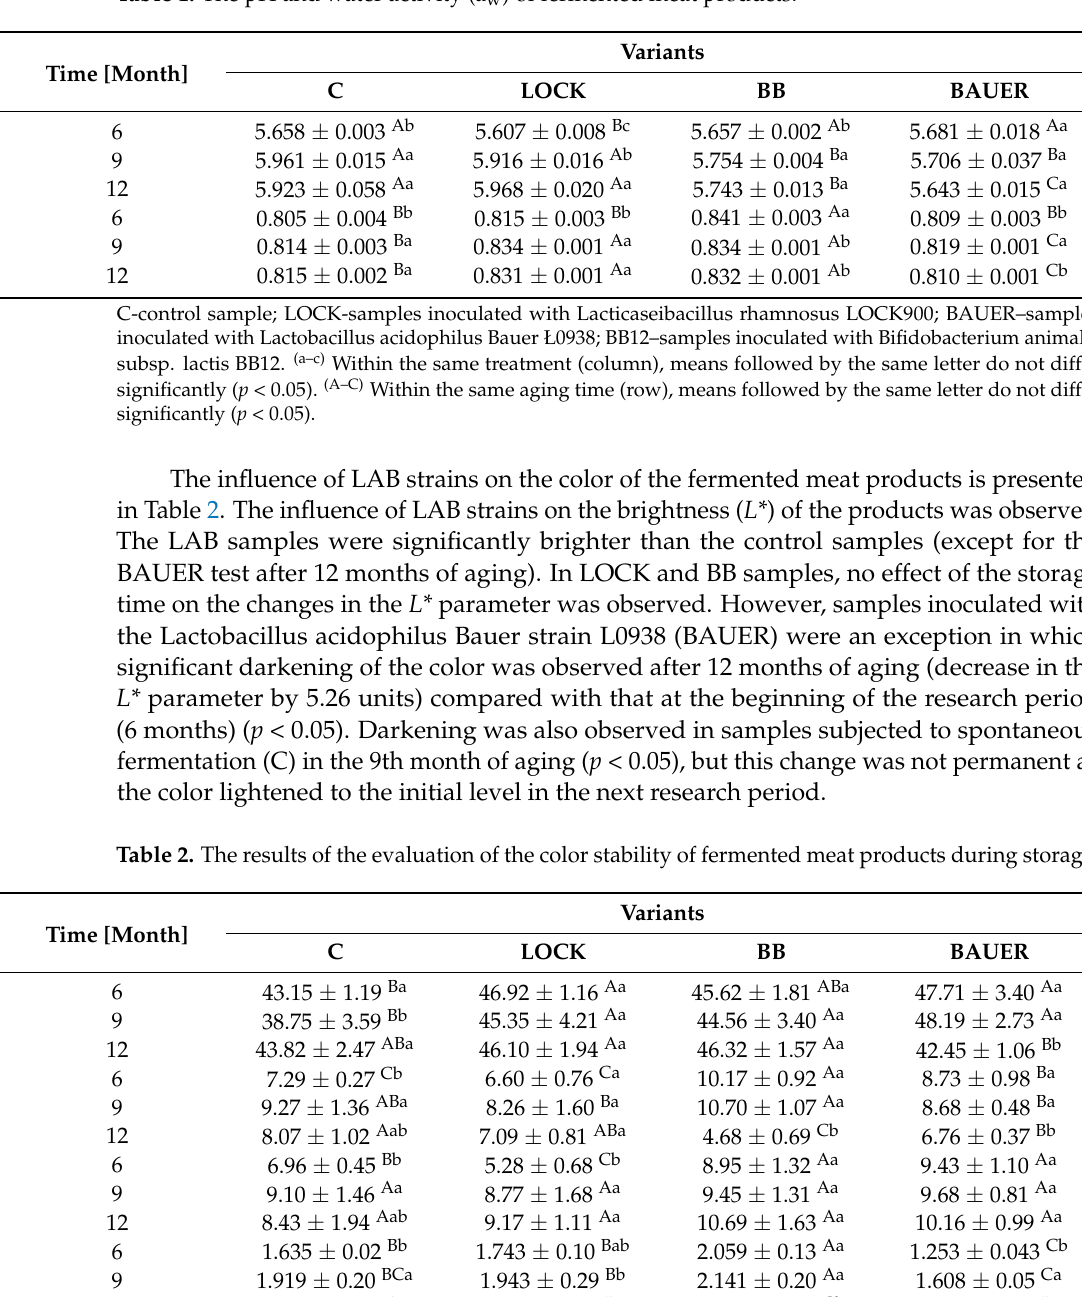
Table 1. The pH and water activity (a w ) of fermented meat products.